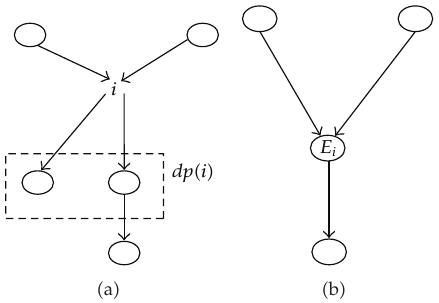
Figure 8: (cid:5) a (cid:6) : fraction of a BN before marginalizing out i . (cid:5) b (cid:6) fraction of a BN2, on S , obtained after summing out i .